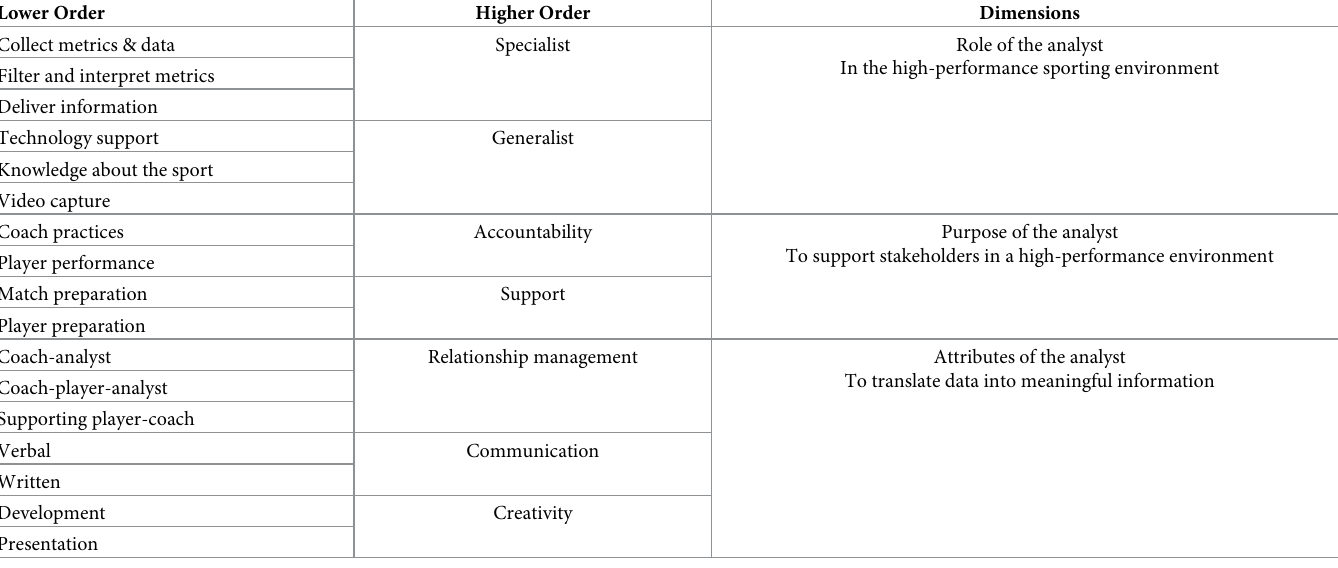
Table 1. List of lower and higher order themes, and dimensions that emerged from semi-structured interviews with professional (n = 5) rugby union coaches. Lower